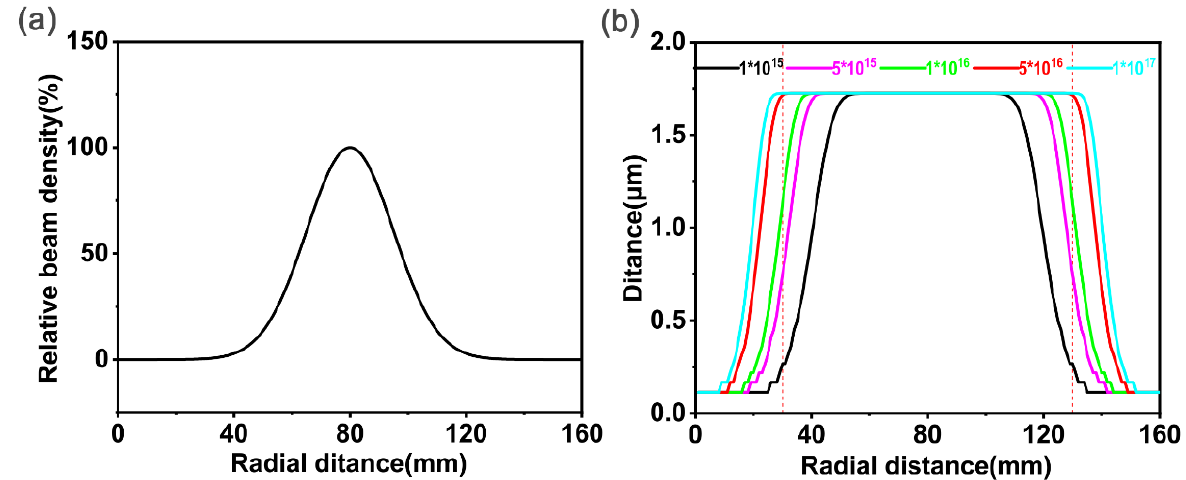
Figure 4. ( a ) Ion beam density distribution. ( b ) Ion beam density distribution’s influence on the total penetration depth of carbon black particles.